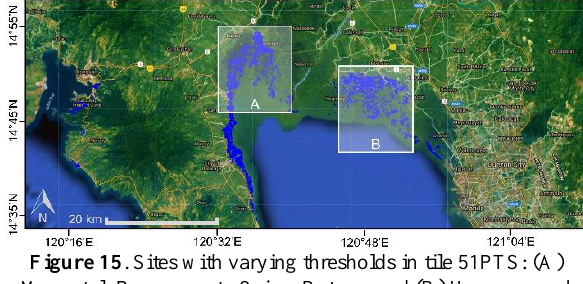
Figure 15 . Sites with varying thresholds in tile 51PTS: (A) Masantol, Pampanga to Orion, Bataan, and (B) Hagonoy and Paombong, Bulacan. The blue pixels are classified as mangroves in the MVI-based 2019 Mangrove Extent Map of the Philippines. The computed areas of mangrove cover in these sites using the original and optimal site-specific thresholds are summarized in Table 2.